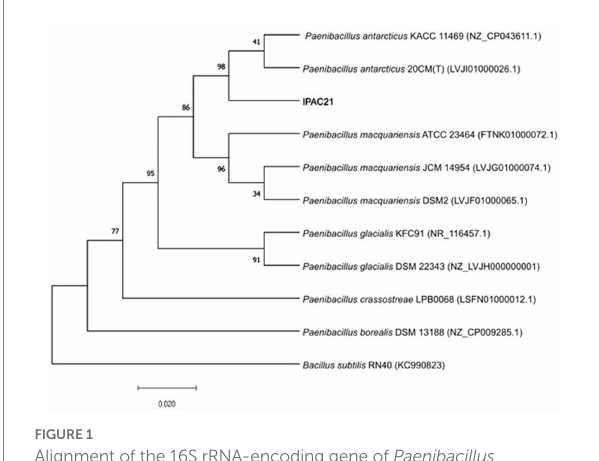
FIGURE 1 Alignment of the 16S rRNA-encoding gene of Paenibacillus antarcticus IPAC21 and related species. The phylogenetic tree was constructed using the maximum likelihood method and the Jukes– Cantor model. The GenBank accession number of each sequence is shown in parentheses. Bootstrap values are expressed as percentages of 1,000 replications and are shown at branch points. Bacillus subtilis RNA40 was used as an